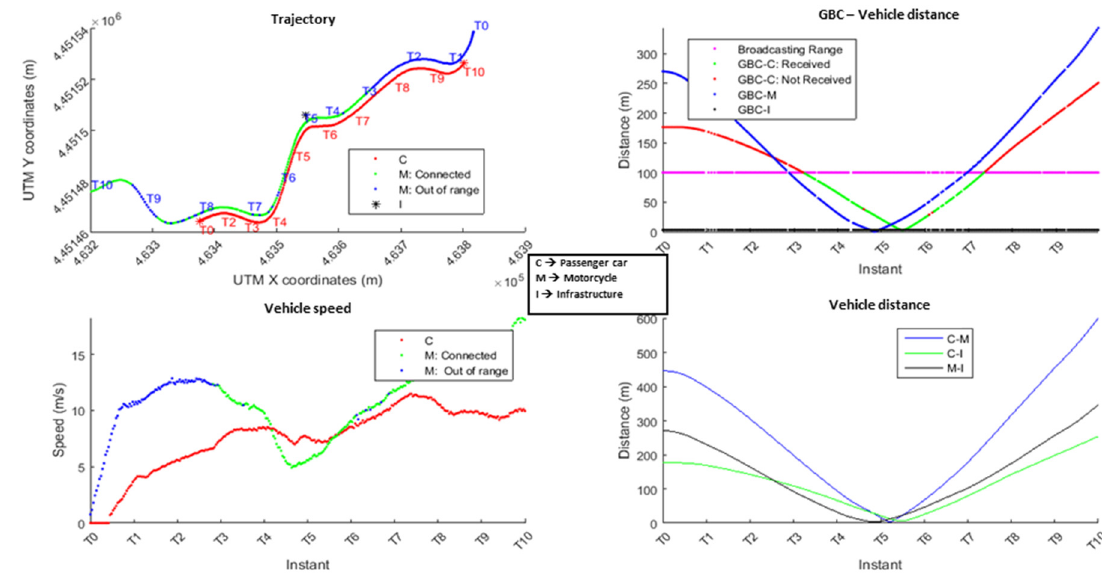
Figure 11. Results of Test 3 with RSU.